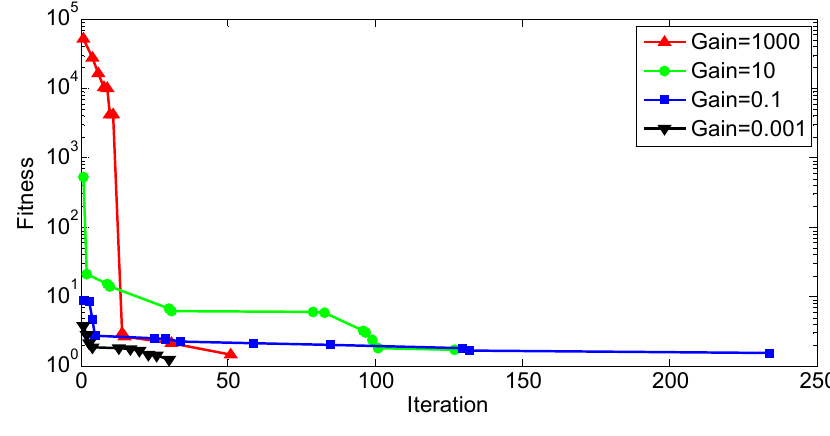
Figure 11. SA convergence history.